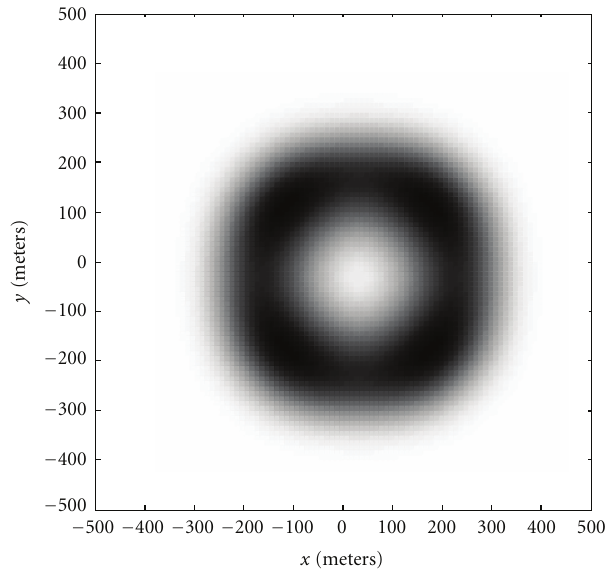
Figure 8: A sample computation of local uncertainty over a surveil- lance area when the underlying target density distribution is a simple Gaussian probability distribution. Local uncertainty is repre- sented by shade value where white is high-local uncertainty and black is low-local uncertainty. In this sample, notice that the peak and the tails of the Gaussian have high-local uncertainty whereas the regions in between the peak and tails have low uncertainty.